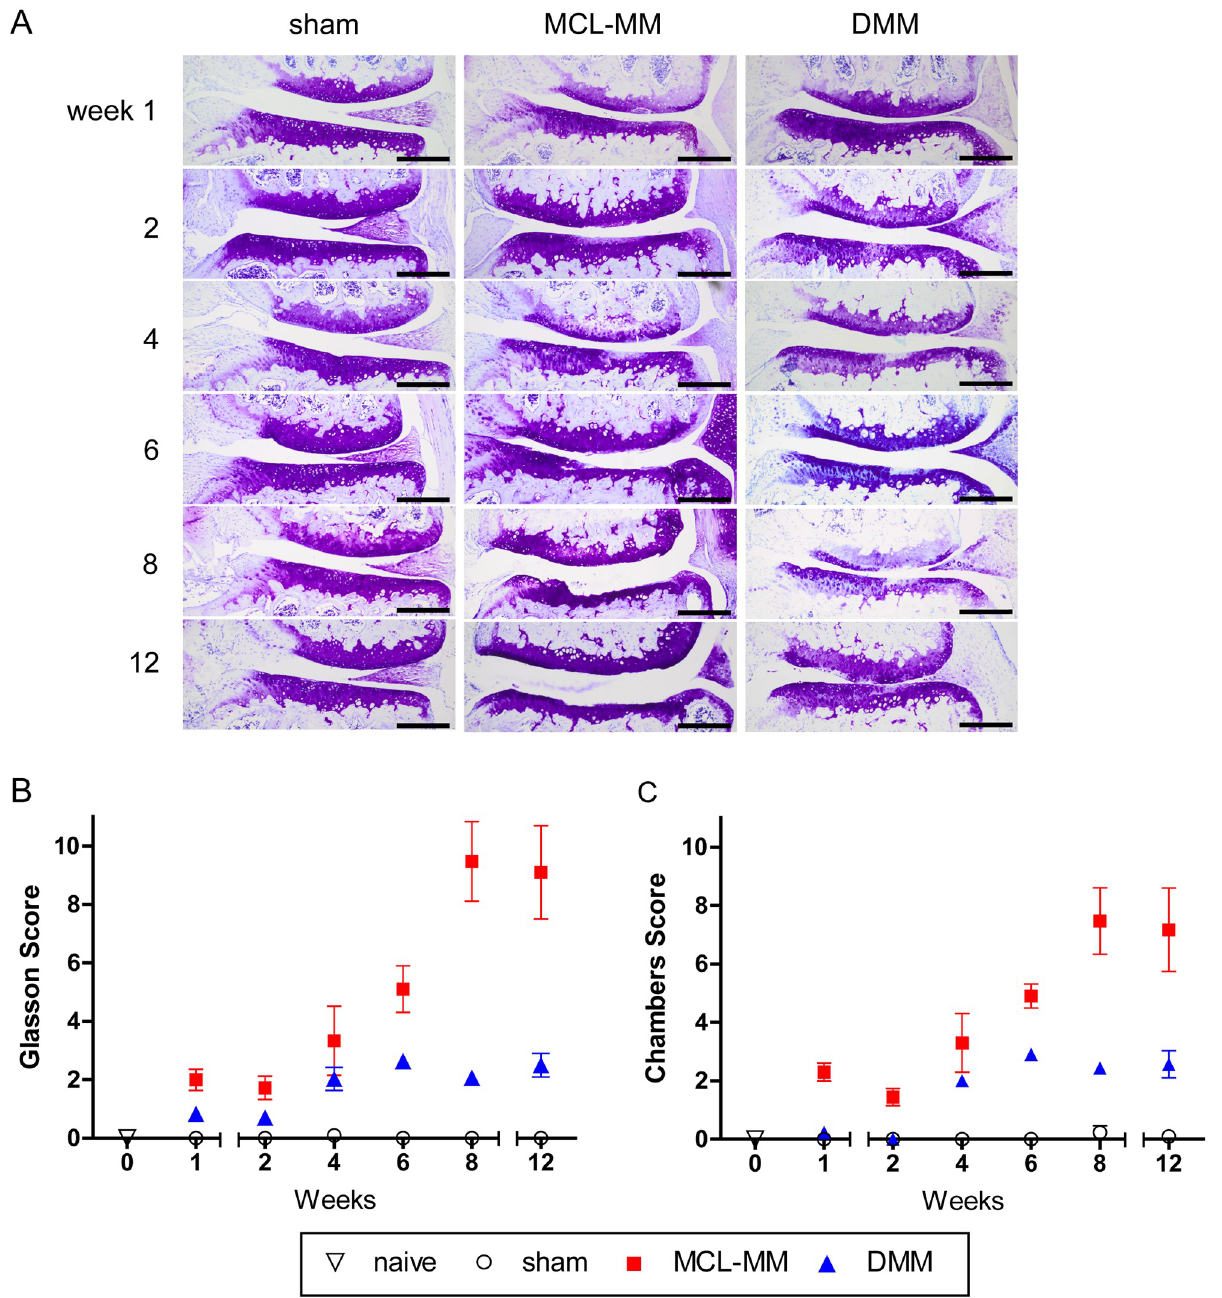
Fig 2. A Toluidine blue stained frontal sections of the medial aspect of mouse knee joints at the indicated time points after sham, MCL-MM, DMM surgery. OA-scoring of cartilage destruction of the medial joint aspect on the basis of the scoring systems of B) Glasson et al. and C) Chambers et al. Data represent mean values ± SEM. � p � 0.05 MCL-MM vs sham; $ p � 0.05 DMM vs sham; # p � 0.05 DMM vs MCL-MM; Bar = 250 μ m.